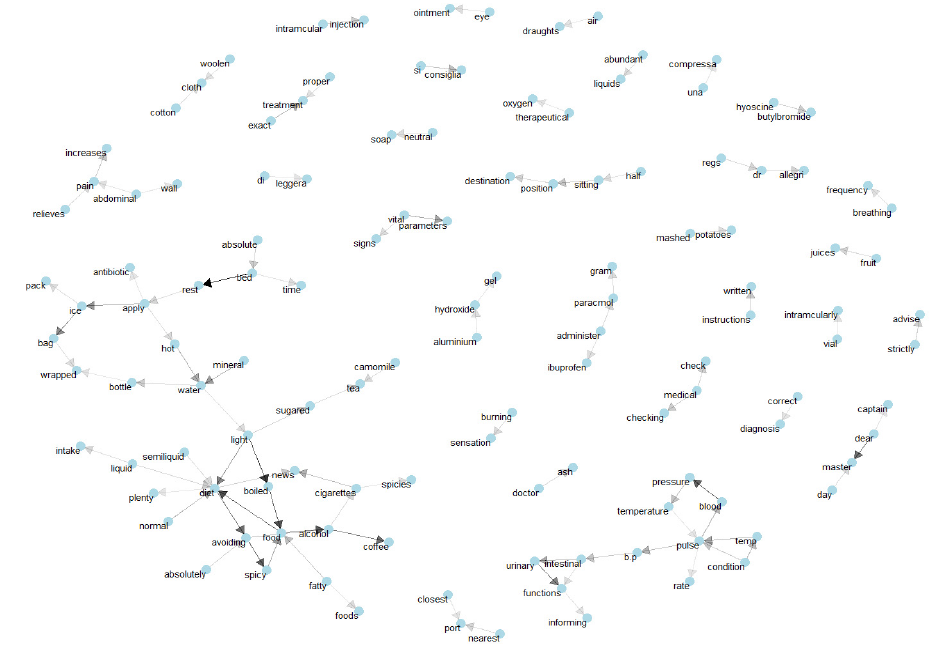
Figure 6. Data visualization networks (Common bigrams that occurred in categorical disease documents).